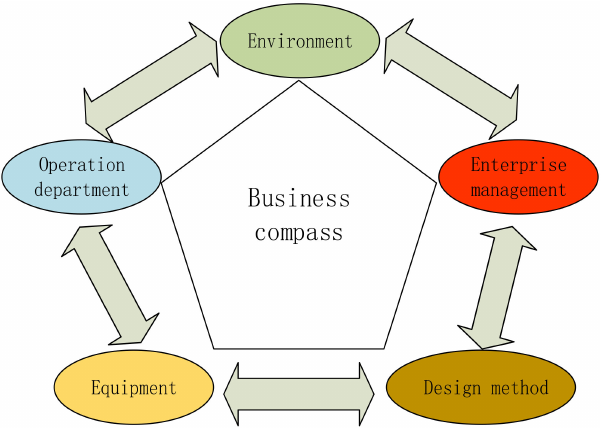
Figure 2. Blank dimension design in business